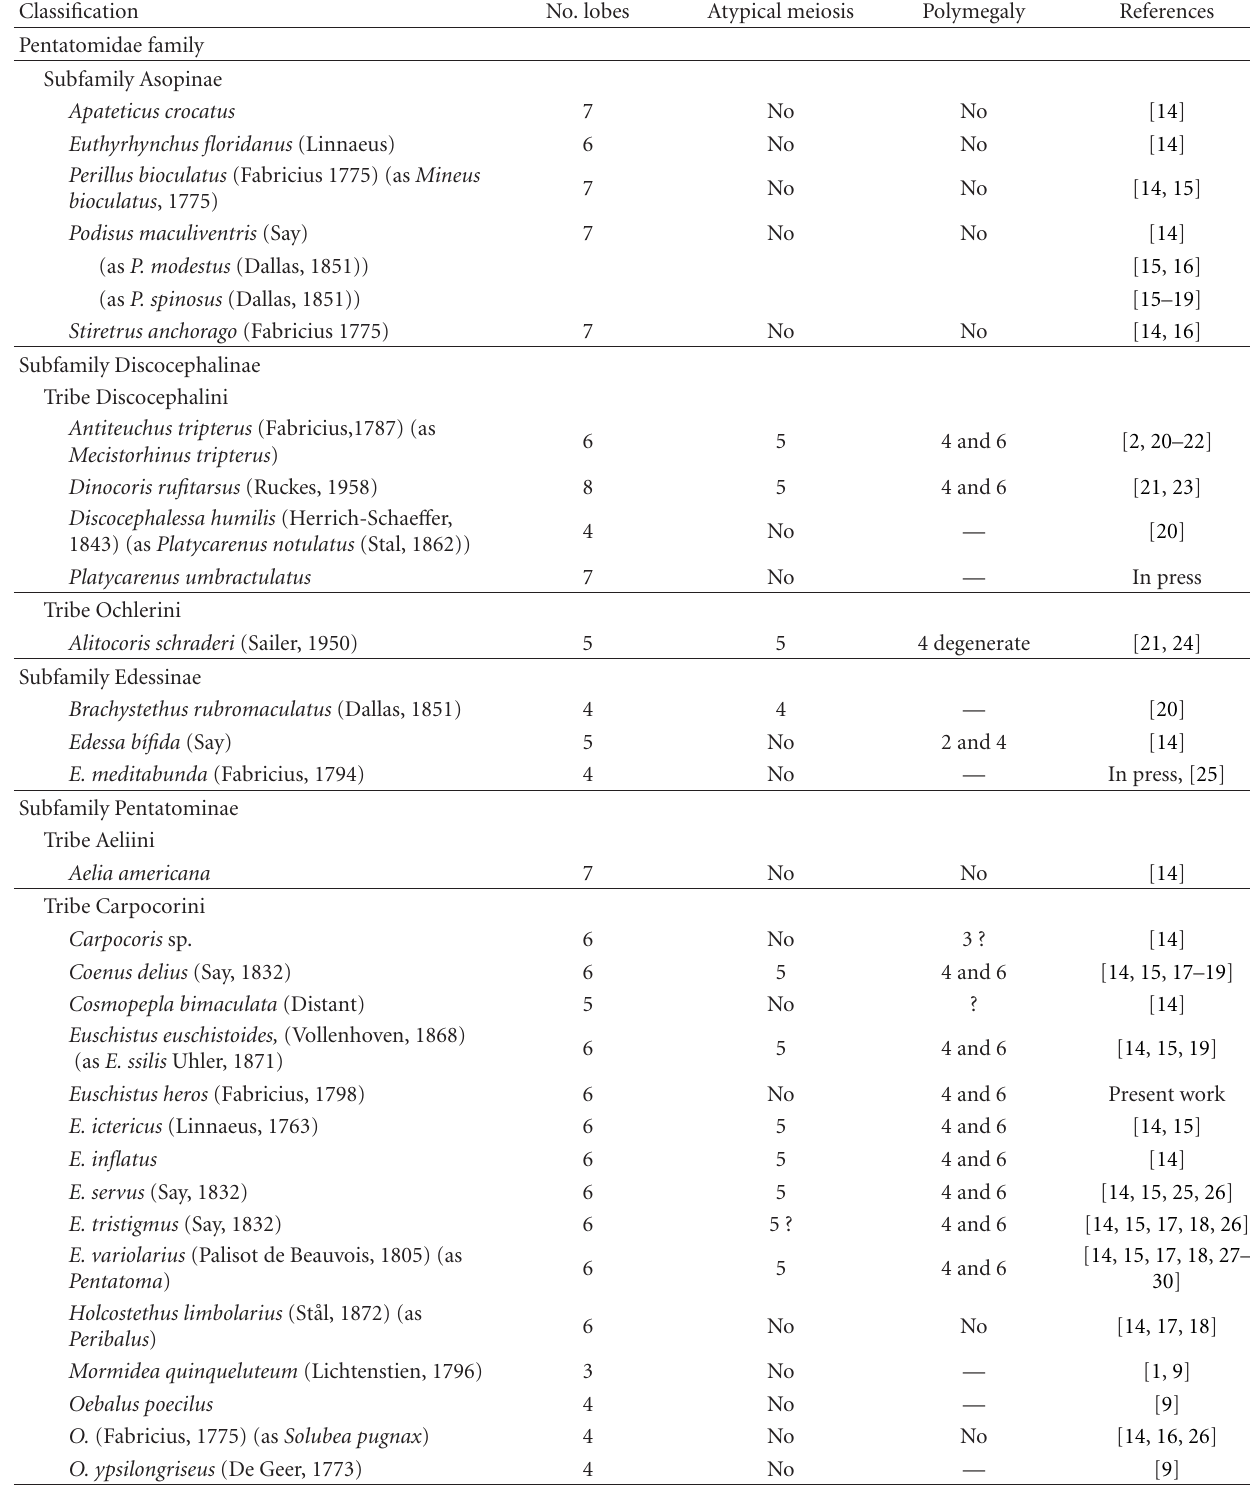
Table 1: All species of the family Pentatomidae in the literature where authors noted the number of testicular lobes and if they exhibited atypical meiosis and polymegaly. “No”: characteristic not found; “—”: information not found, “?”: author not sure about the presence of the